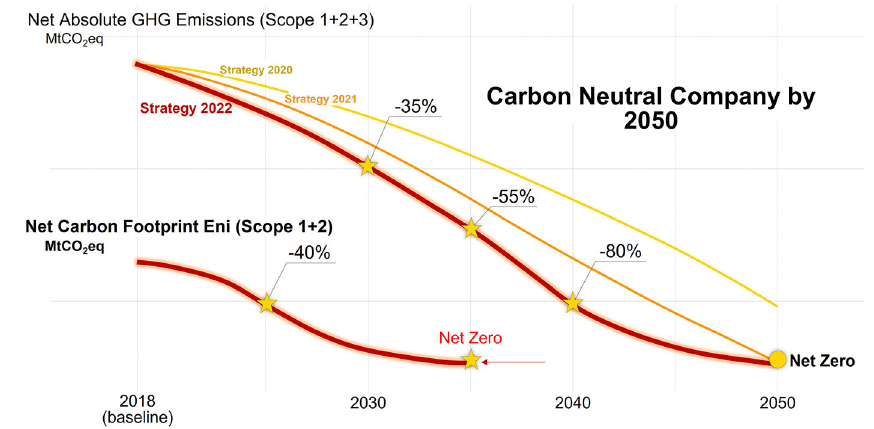
Fig. 24. – Accelerating Eni’s Greenhouse Gas emission targets (Source: Eni, 2022).